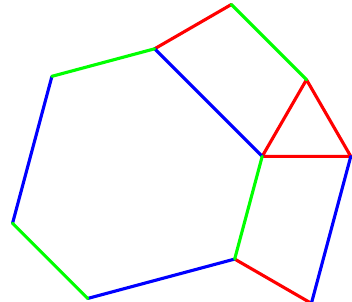
Fig. 6: The second possible corona with triangle, two quadrilaterals, and hexagon.